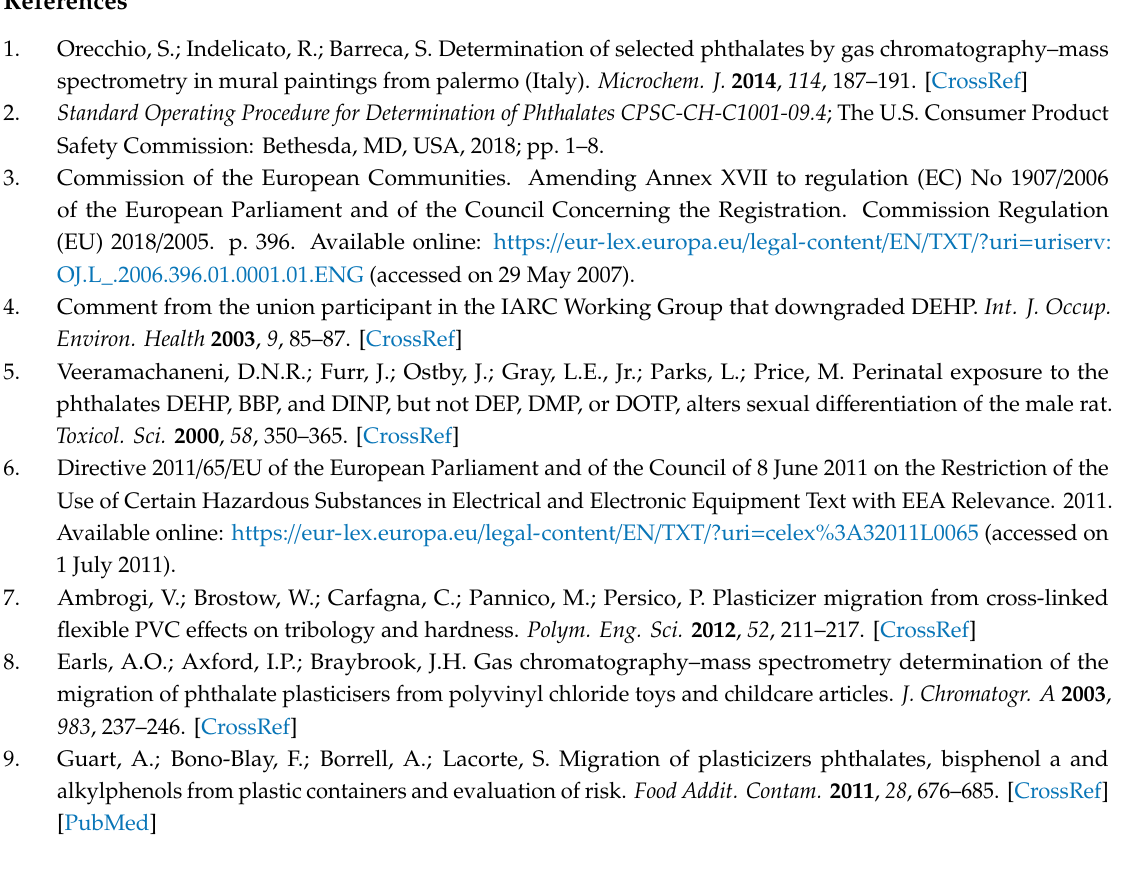
Table S1: List of quantitative and confirmation ions. Table S2: Thermal desorption (TD) heating conditions and gas chromatography–mass spectrometry (GC–MS) parameter settings for Deca-BDE. Table S3: Concentration of Deca-BDE in the sample after 21 h of contact with a PET sheet containing 22% (w / w) Deca-BDE. Figure S1: FT-IR spectra of various polymers. (a) PE sheet after 352 h of contact with a PVC sheet containing 7.4% (w / w) DEHP; (b) PVC containing 7.4% (w / w) DEHP; (c) standard DEHP spectrum retrieved from OMNIC 7.3 library. FT-IR was not sensitive enough to detect DEHP’s migration at the regulatory level. Figure S2: Schematic of DEHP migration test from PVC (plasticized) to solvent